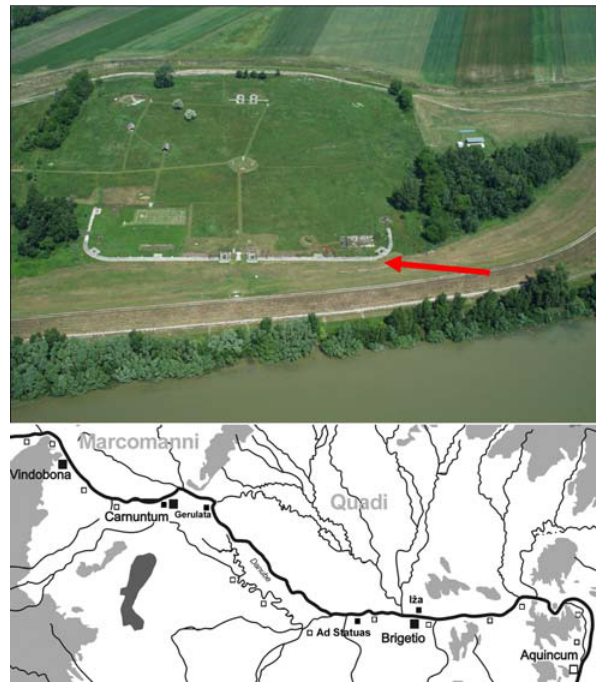
Figure 1: Roman fort at I ž a - Leànyvàr. Red arrow indicates where the bone fi gure was probably found ( Photo: Ivan Kuzma, AU SAV Nitra )